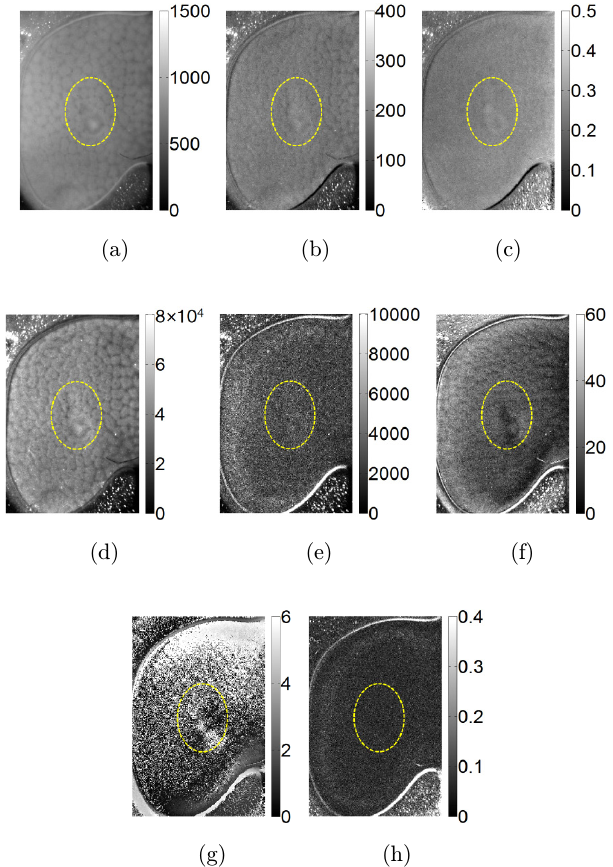
Fig. 2. Experimental results: (a) intensity, (b) DP, (c) DOP, (d) RLPI(B), (e) RLPI(A), (f) RLPI(C), (g) RLPI( ’ 3 = 2) and (h) RLPI(G) for a nude mouse's liver tissue with human colon carcinoma HCT116. The carcinoma areas are marked by yellow circle